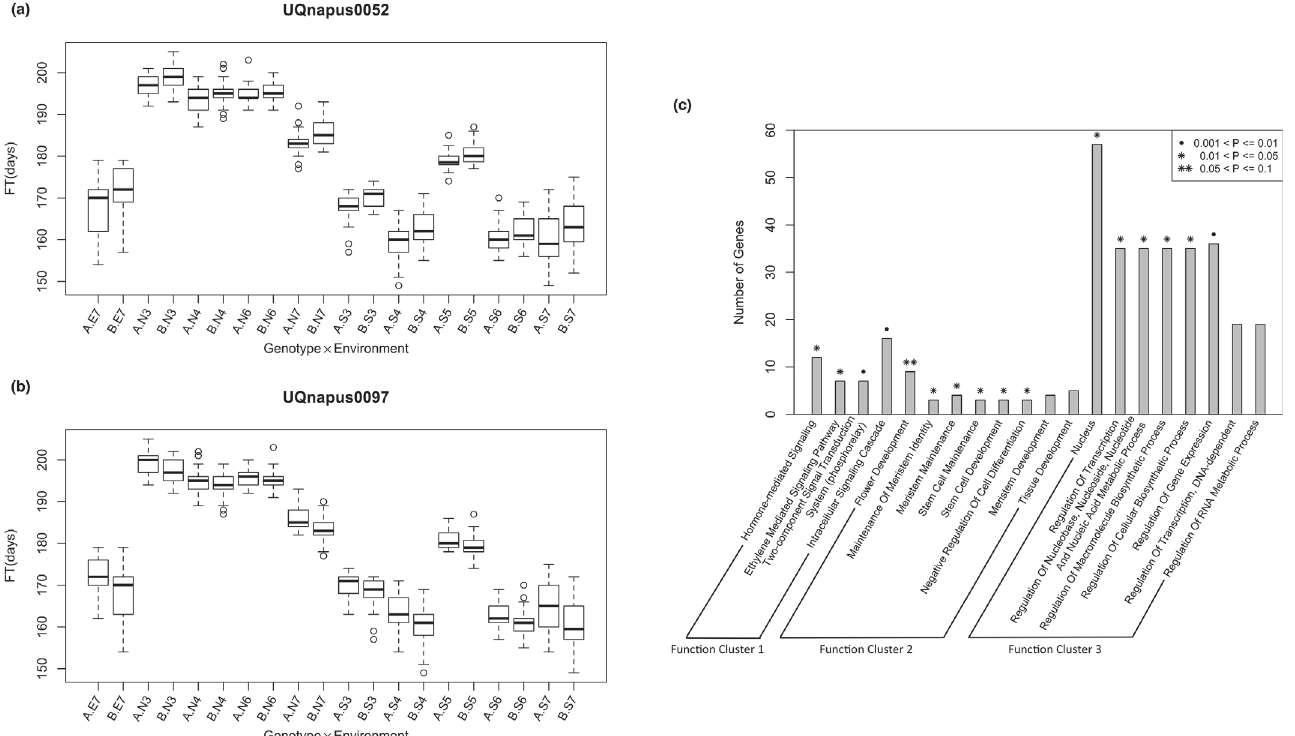
Fig 4. Illustration of genotype effects of associated SNPs on FT and functional clusters of genes tagged by detected SNPs. ( a) Samples with allele ‘ A ’ at UQnapus0052 tend to blossom earlier than the ones with allele ‘ B ’ (with t test P-value from 3.47 ×10 − 9 to 3.95 ×10 − 1 ). ( b) while at UQnapus0097, lines with allele ‘ B ’ are more likely to flower sooner (with t test P-value from 1.23 ×10 − 7 to 1.44 ×10 − 1 ). (c) Functional clusters with enrichment score > 1.3 (corresponding to p value of